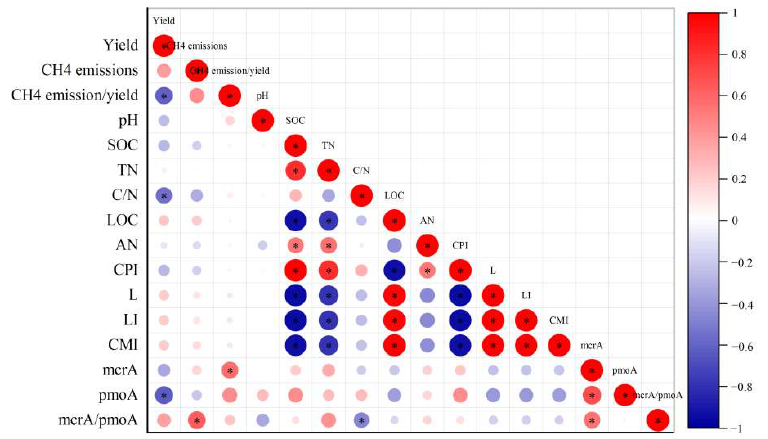
Figure 5. Correlation analysis between grain yield, CH 4 emissions and soil index. Red circle and blue circle refer to positive correlation and negative correlation, respectively. * p < 0.05.